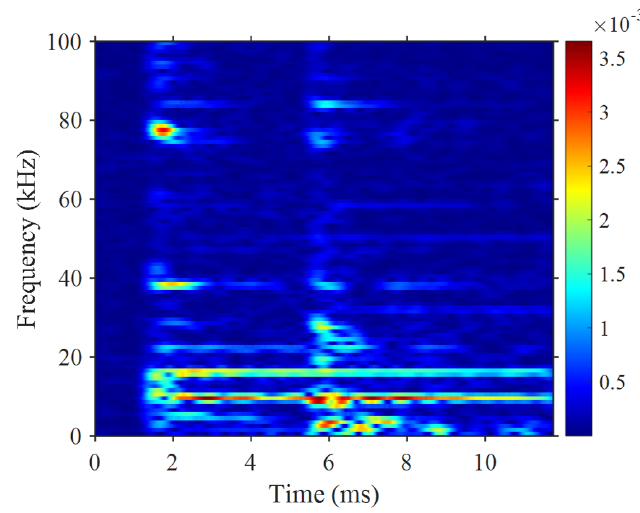
Figure 7. Time–frequency spectrum obtained by